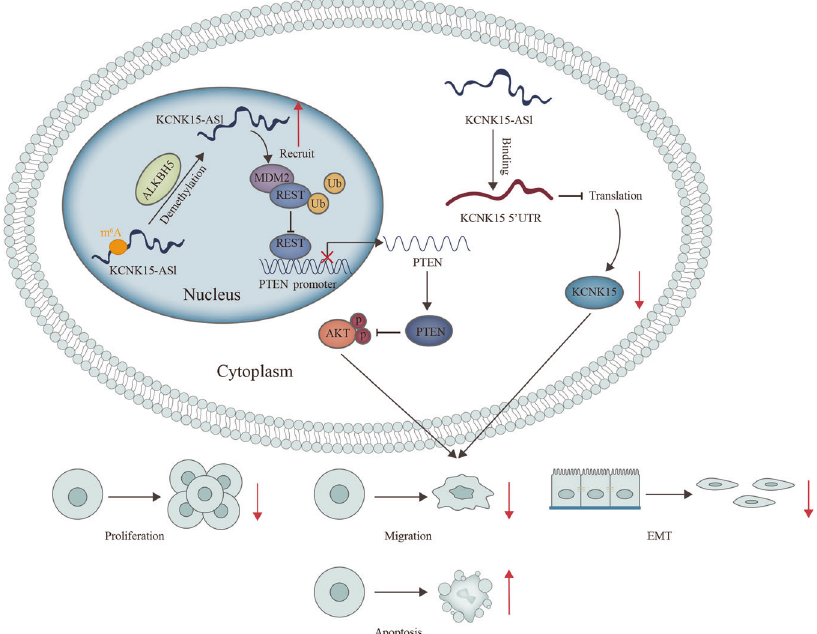
Fig. 7 A graphical abstract was plotted to illustrate the function and mechanism of KCNK15-AS1 in pancreatic cancer. Graphical abstract illustrates the up- and down-stream mechanisms of KCNK15-AS1 in PC